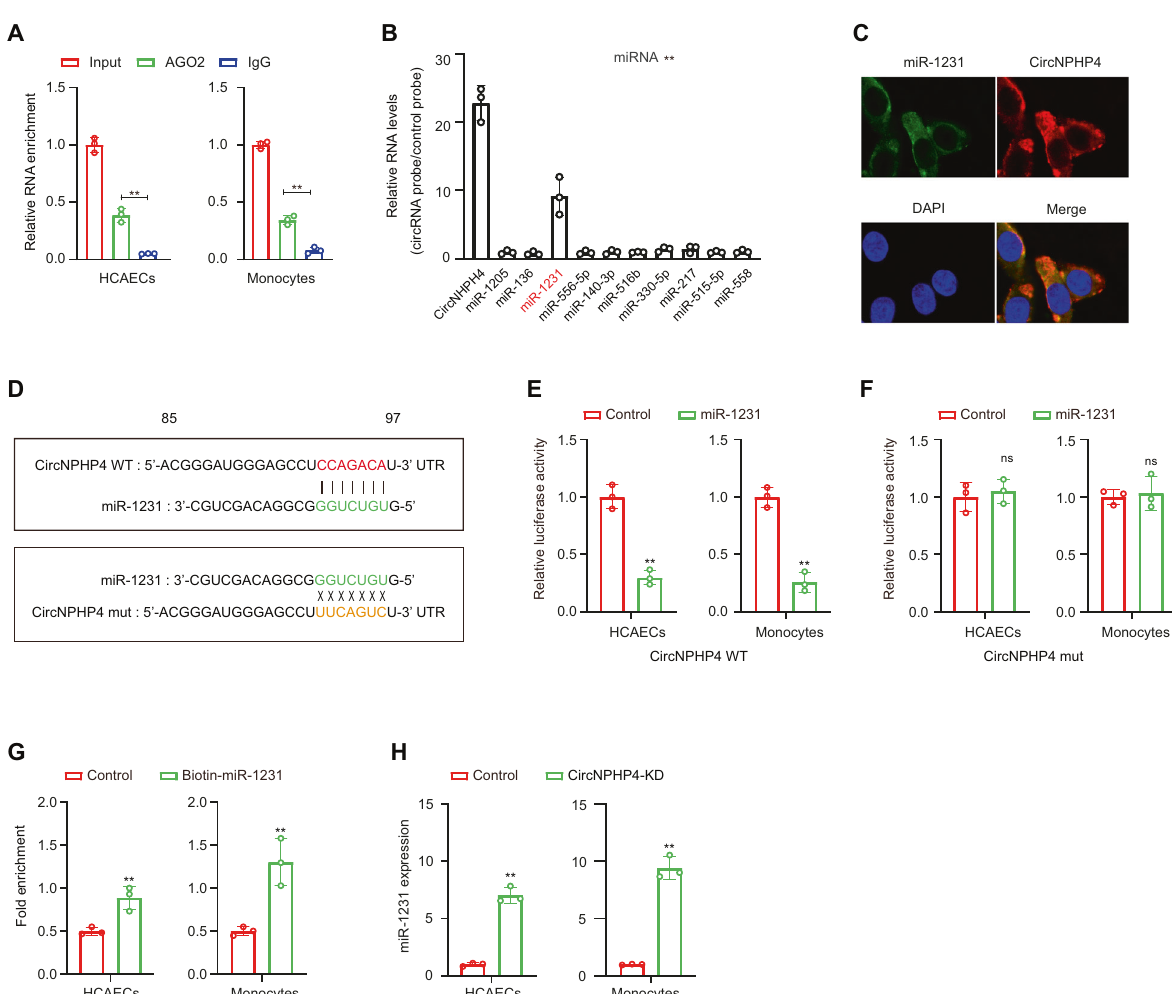
Fig. 6 CircNPHP4 acted as a miRNAs sponge for miR-1231. A RIP was performed using an antibody against AGO2 on extracts from monocytes and HCAECs. B CircNPHP4 was performed using a circNPHP4-speci fi c probe and control probe in HCAECs. The enrichment of circNPHP4 and microRNAs were detected by qRT-PCR and normalized to the control probe. C Co-localization between circNPHP4 and miR- 1231 was observed by RNA in situ hybridization in HCAECs. Nuclei were stained with DAPI. Scale bar = 20 µm. D Schematic showing the predicted miR-1231 sites in circNPHP4. A Luciferase assay where monocytes were co-transfected with a scrambled control, miR-1231 mimic, and a luciferase reporter plasmid containing wild-type circNPHP4 (circNPHP4-WT) ( E ) or mutant circNPHP4 (circNPHP4-mut) ( F ). G qRT-PCR showed the level of circNPHP4 in the streptavidin-captured fractions from the monocytes and HCAECs lysates after transfection with biotinylated miR-1231 or control RNA. H Expression of miR-1231 was analyzed using qRT-PCR following circNPHP4 knockdown. Data are presented as means ± SD; a signi fi cant difference was identi fi ed with Student ’ s t test. * P < 0.05; ** P < 0.01; ns (not signi fi history, exosomal circNPHP4 expression, serum circNPHP4 circNPHP4 were obtained using serum from CAD patients and the expression and type 2 diabetes mellitus (T2DM). The results of control group (Fig. 8B). We also analyzed the association between the logistic regression analysis are given in Fig. 8I. Next, the circNPHP4 expression and the clinicopathological status of CAD model that incorporated the above independent predictors was patients (Supplementary Table 6). CircNPHP4 expression using developed and is presented as a nomogram (Fig. 8J). Our results serum or serum sEVs was positively correlated with the SYNTX also showed that the calibration curve of the nomogram for the scale ( P < 0.01) in CAD patients (Fig. 8C, D). Furthermore, ROC prediction of the risk of CAD demonstrated good agreement analysis was performed with a circNPHP4 cutoff ≥ 5.041 and (Fig. 8K). The C-index for the predictive nomogram was 0.927 showed a high diagnostic performance using serum sEVs, as (95% con fi dence interval: 0.917-0.937) for the primary cohort, re fl ected by the Youden index (sensitivity, 87.1%; speci fi city, and a C-index of 0.921 was con fi rmed with bootstrapping 69.7%; Fig. 8E). Parallel results of ROC analysis were obtained using validation, which suggests that the nomogram has a good serum samples (Fig. 8F). discriminatory ability. The performance parameters of the To overcome the limitations of probabilistic prediction nomogram for the risk of CAD had a good predictive capability. models, we constructed a feature selection and developed an We also performed decision curve analysis for the CAD individualized predictive model that can be used to facilitate nomogram, as shown in Fig. 8L. The decision curve showed that medical decisions based on the decision maker ’ s preferences. if the threshold probabilities of a patient and a doctor were >2% First, there were 9 potential predictors in the cohort (Fig. 8G, H) and <96%, respectively, using this CAD nomogram to predict the that had nonzero coef fi cients in the LASSO regression model: risk of CAD added more bene fi t than the scheme. In addition, age, sex, blood pressure, Apo-a, LPA, alcohol consumption